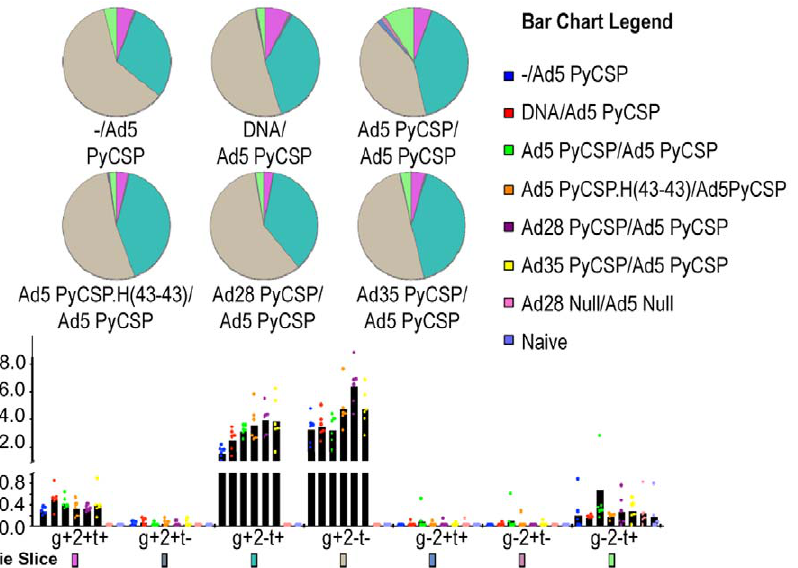
Figure 7. Polyfunctional T cell responses following different vaccine regimens. Splenocytes from mice immunized as in Figure 6 (n=6) were analyzed for polyfunctional CD8 + T cell responses following stimulation with A20.2J cells pulsed with a synthetic peptide representing the immunodominant CD8 + T cell epitope ( Py CSP280–288). Responses were measured by ICS for IFN c , IL-2 and TNF a . Black bars indicate the mean percentage of cells positive for each combination of cytokines. Responses from individual animals are shown by the colored dots. (g=IFN c , 2=IL2, t=TNF a ). Pie charts indicate the fraction of the total response comprising cells expressing each of the seven possible combinations of IFN c , IL-2 and TNF a